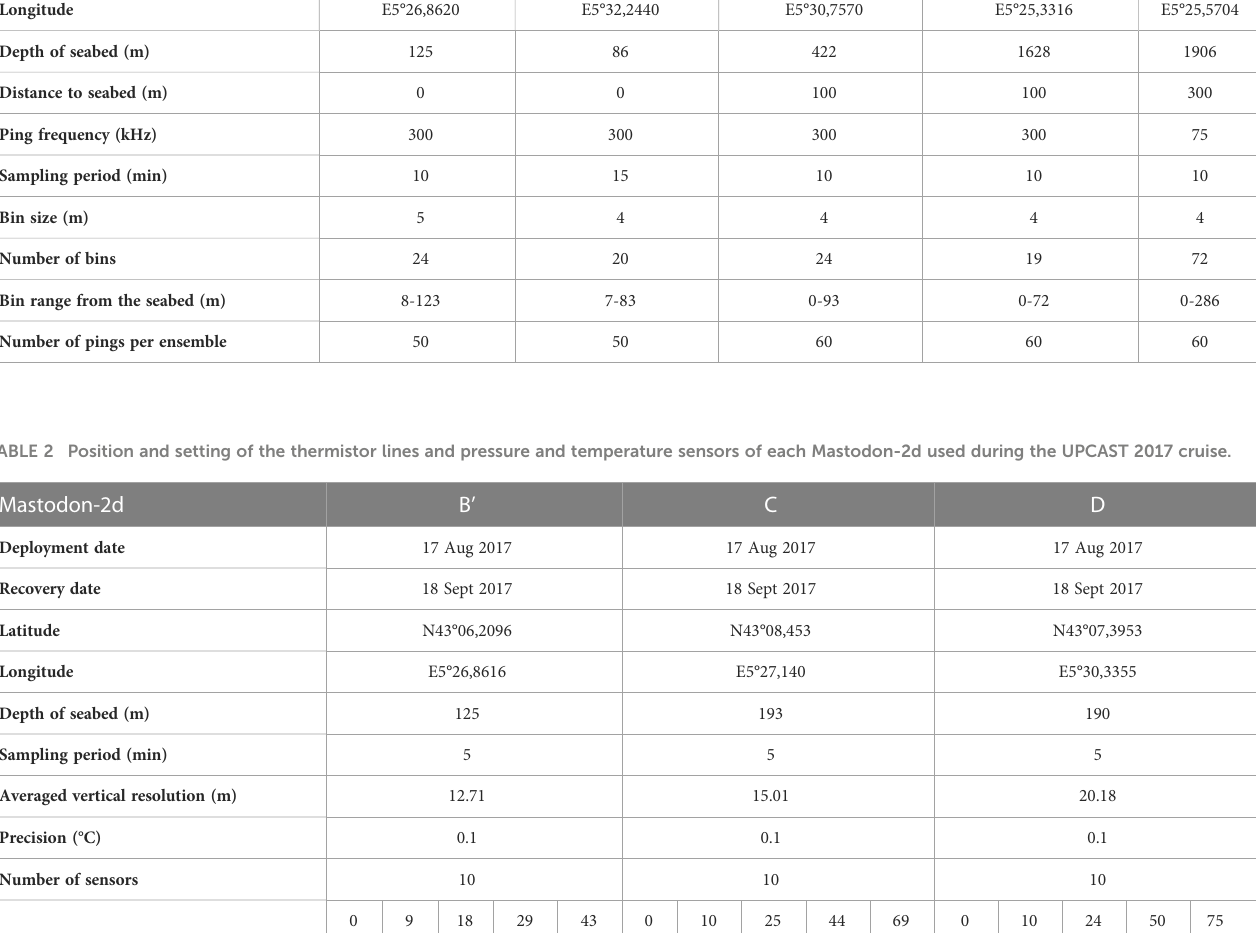
TABLE 1 Position and setting of each ADCP mooring used during the UPCAST 2017 and CASSISED 2019 cruises. Mooring B Shelf PG1 PG2 Aniitra